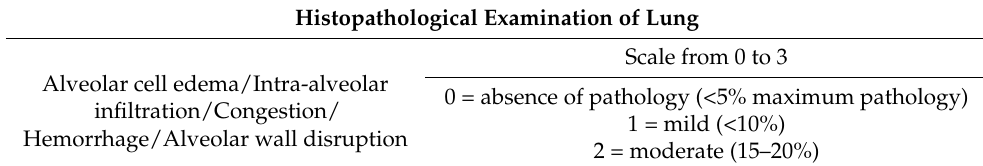
Table 2. Histopathological examination (xcoring).